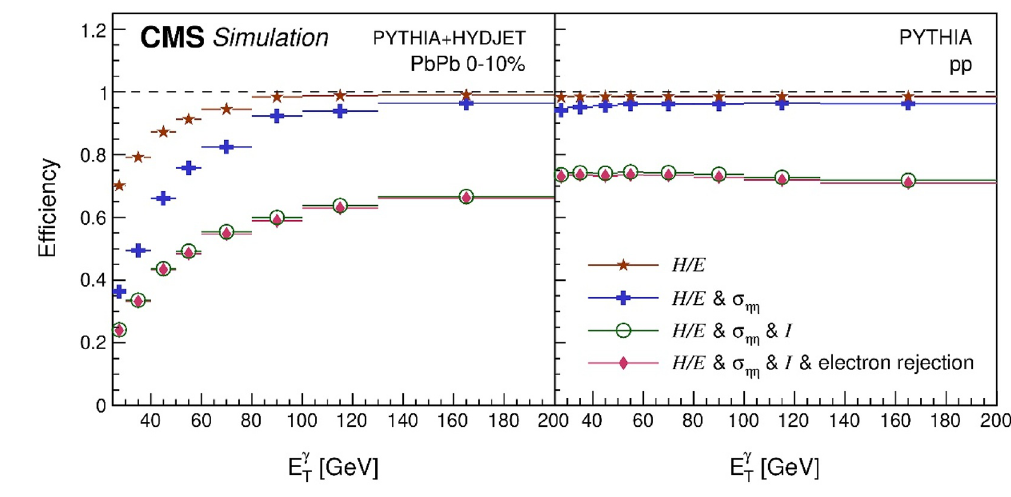
Figure 2 . E(cid:14)ciency of the isolated photon detection as a function of E g for PbPb collisions in T the 0{10% centrality range (left) and for pp data (right). The di(cid:11)erent colors represent various selection criteria: H=E < 0 : 1, (cid:27) < 0 : 01, I < 1 GeV and electron rejection (cid:17)(cid:17)